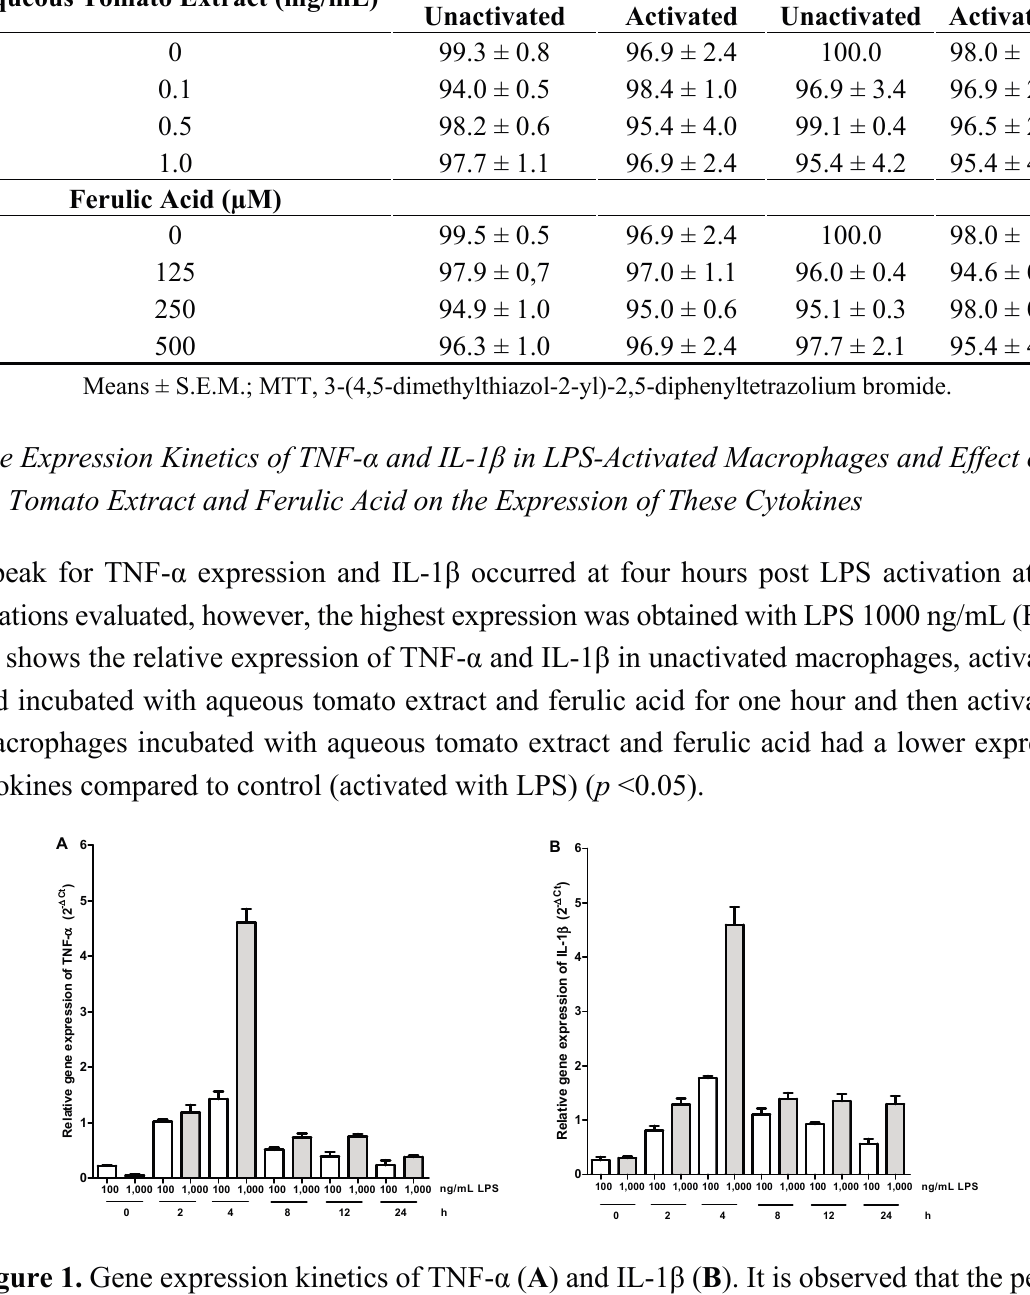
Table 1. Aqueous tomato extract and ferulic acid does not affect the viability of macrophages. Viability by Trypan Blue (%) Aqueous Tomato Extract (mg/mL)